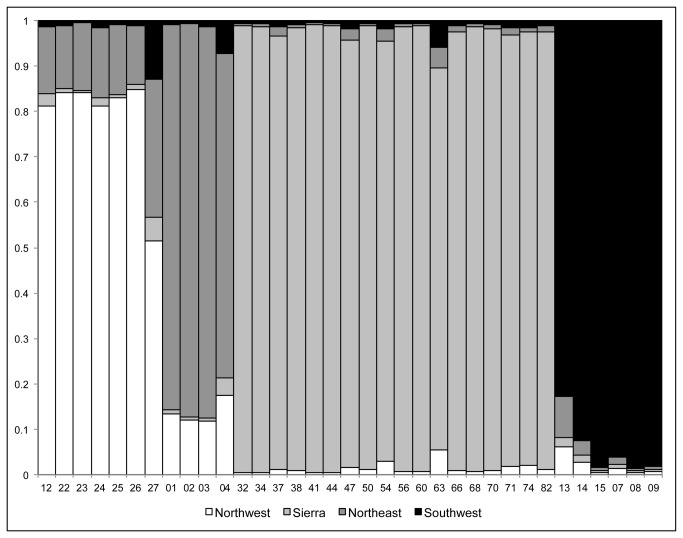
Population clustering results from the STRUCTURE analysis for Rhodiola integrifolia.The four cluster model (K = 4) shown was the most likely population model (mean ln likelihood = -352.2). The different fill shades denote separate population clusters as labeled. The vertical bars represent the proportion of the estimated cluster membership for each individual. Sample numbers are given along the bottom axis.